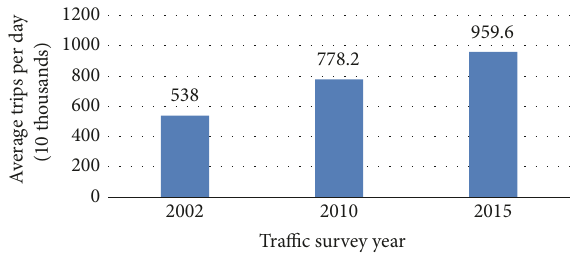
Figure 1: Average trips per day in the 3 traffic surveys of Qingdao.